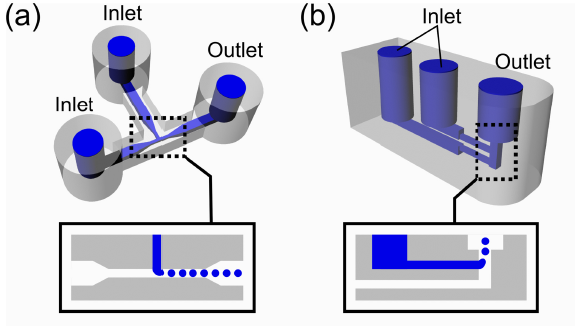
Figure 19. 3D printed droplet generators. ( a ) T ‐ junction device with one aqueous inputs, one oil input, and one output. The aqueous phase was introduced from the top inlet and oil phase from the left; ( b ) The aqueous phase was cut into small droplets by oil phase. (Reproduced with permission from [24].)